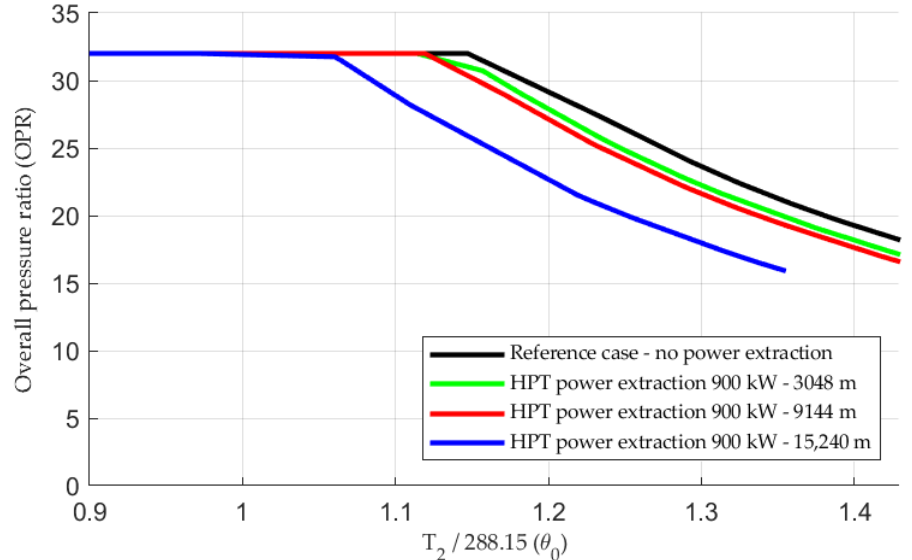
Figure 8. Schematic T-S diagram to explain how power extraction can improve SFC at afterburner operation when core fuel flow and turbine inlet temperature increase while afterburner fuel flow decreases.